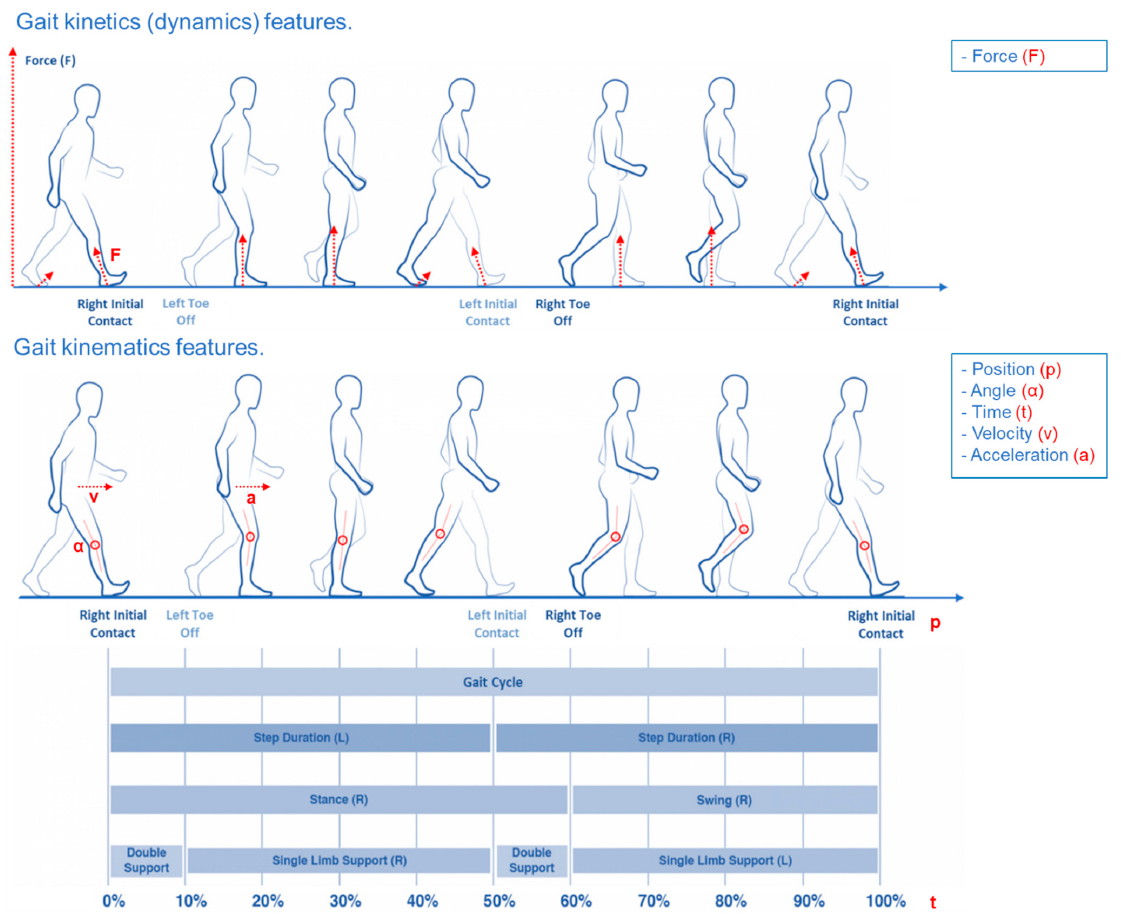
Figure 1. Gait kinetics (upper figure) and kinematics features (lower figure) (modified under the terms and conditions of the Creative Commons Attribution (CC BY) license from [21]).